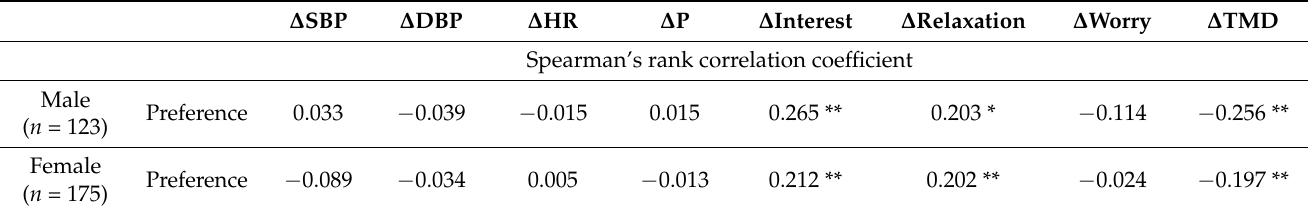
Table 6. Spearman correlation analysis among physiological response changes, emotional response changes, and